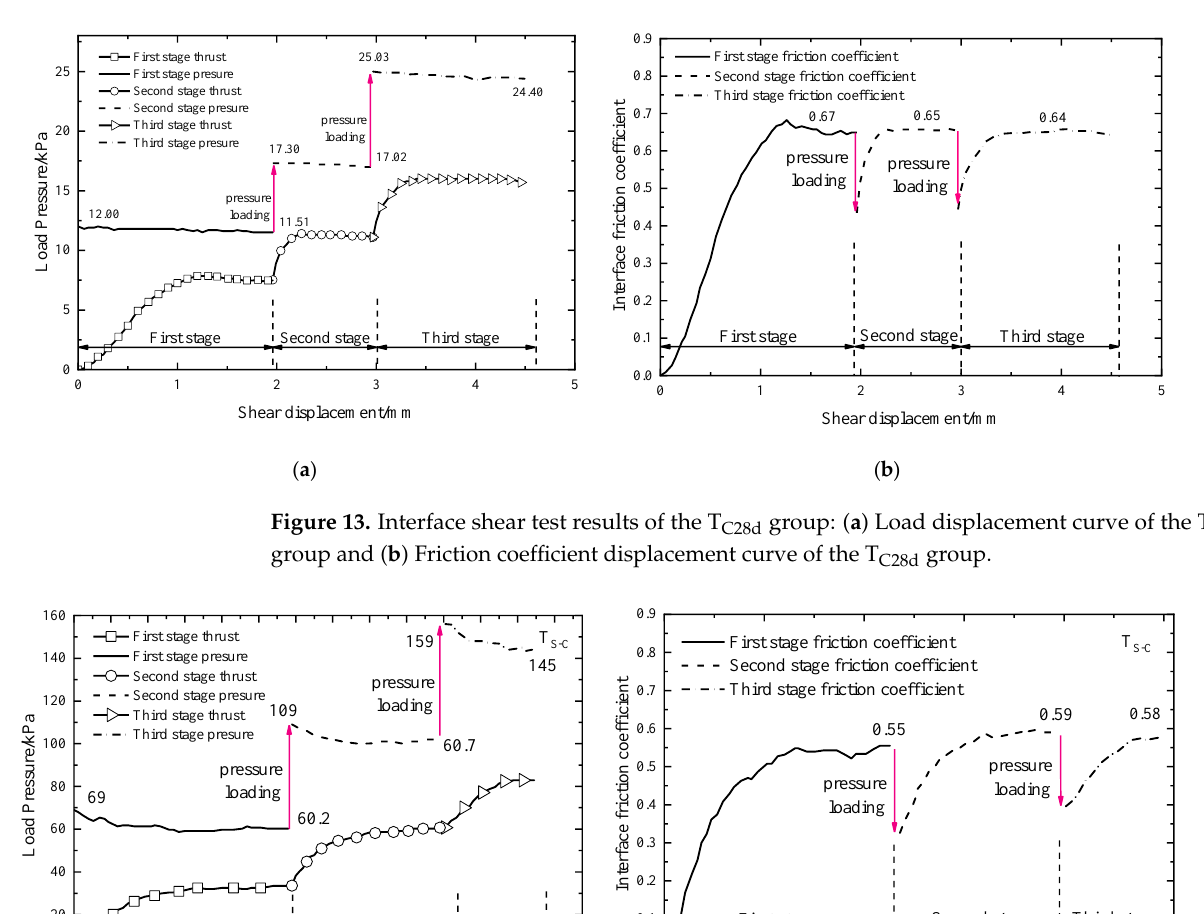
Figure 12. Interface shear test results of the T C14d group: ( a ) Load displacement curve of the T C14d group and ( b ) Friction coefficient displacement curve of the T C14d group.